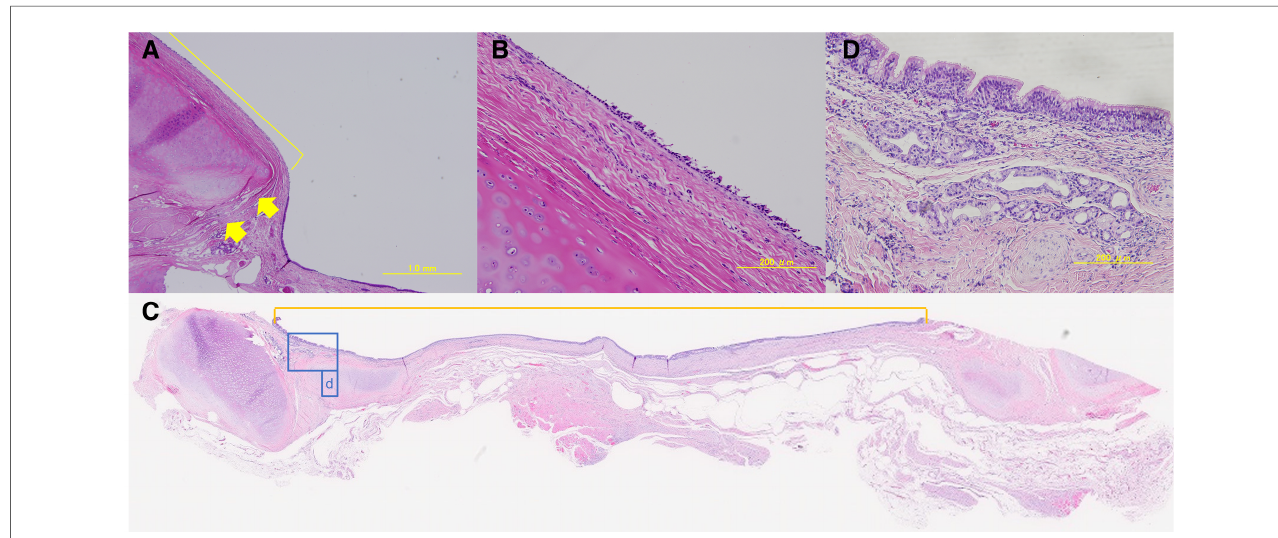
FIGURE 7 ( A,B ) Group A : hematoxylin-eosin-stained sample of the graft-host boundary (4× and 20×). Boundaries are indicated by arrows. The yellow line indicates the graft site. Epithelialization was poor. ( C ) Group B : hematoxylin-eosin-stained sample of the graft-host boundary (loupe). The inside of the scale is on the graft site. The tracheal epithelium was present in a continuous border plane. The area surrounded by a blue line ( D ) indicates the graft site. ( D ) Group B : hematoxylin-eosin-stained graft sample (20×). Pseudostrati fi ed ciliated epithelium, bronchial glands, and elongation of blood vessels, which are structures of normal tracheal epithelium, were